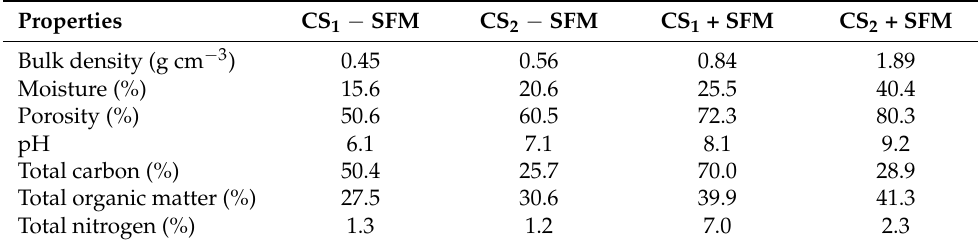
Table 1. Main physical and chemical properties of the compost materials (brassica straw and house- hold waste) with and without the addition of sugarcane filter